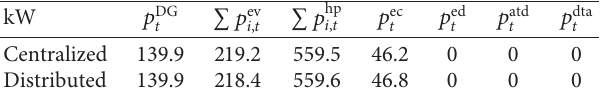
Table 3: Comparison between centralized and distributed solu- tions (take hour t 12 as an example).